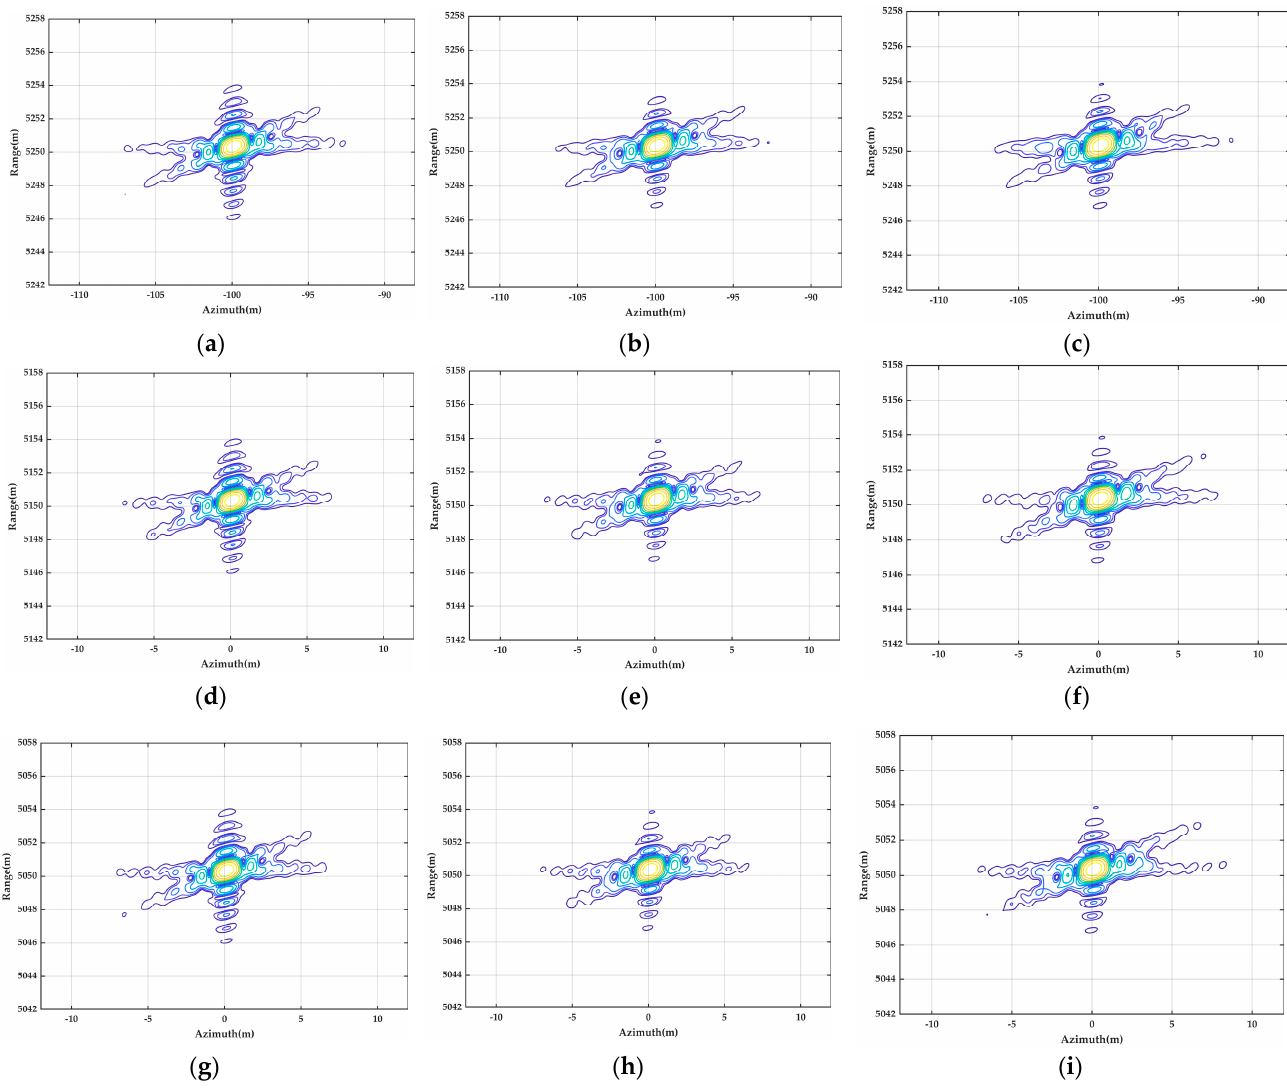
Figure 11. The counter plots of the impulse response of the selected point targets. ( a ) The target A focused by the bistatic BP algorithm; ( b ) The target A focused by the bistatic EP FFBP algorithm; ( c ) The target A focused by the proposed bistatic FFBP algorithm; ( d ) The target B focused by the bistatic BP algorithm; ( e ) The target B focused by the bistatic EP FFBP algorithm; ( f ) The target B focused by the proposed bistatic FFBP algorithm; ( g ) The target C focused by the bistatic BP algorithm; ( h ) The target C focused by the bistatic EP FFBP algorithm; ( i ) The target C focused by the proposed bistatic FFBP algorithm.